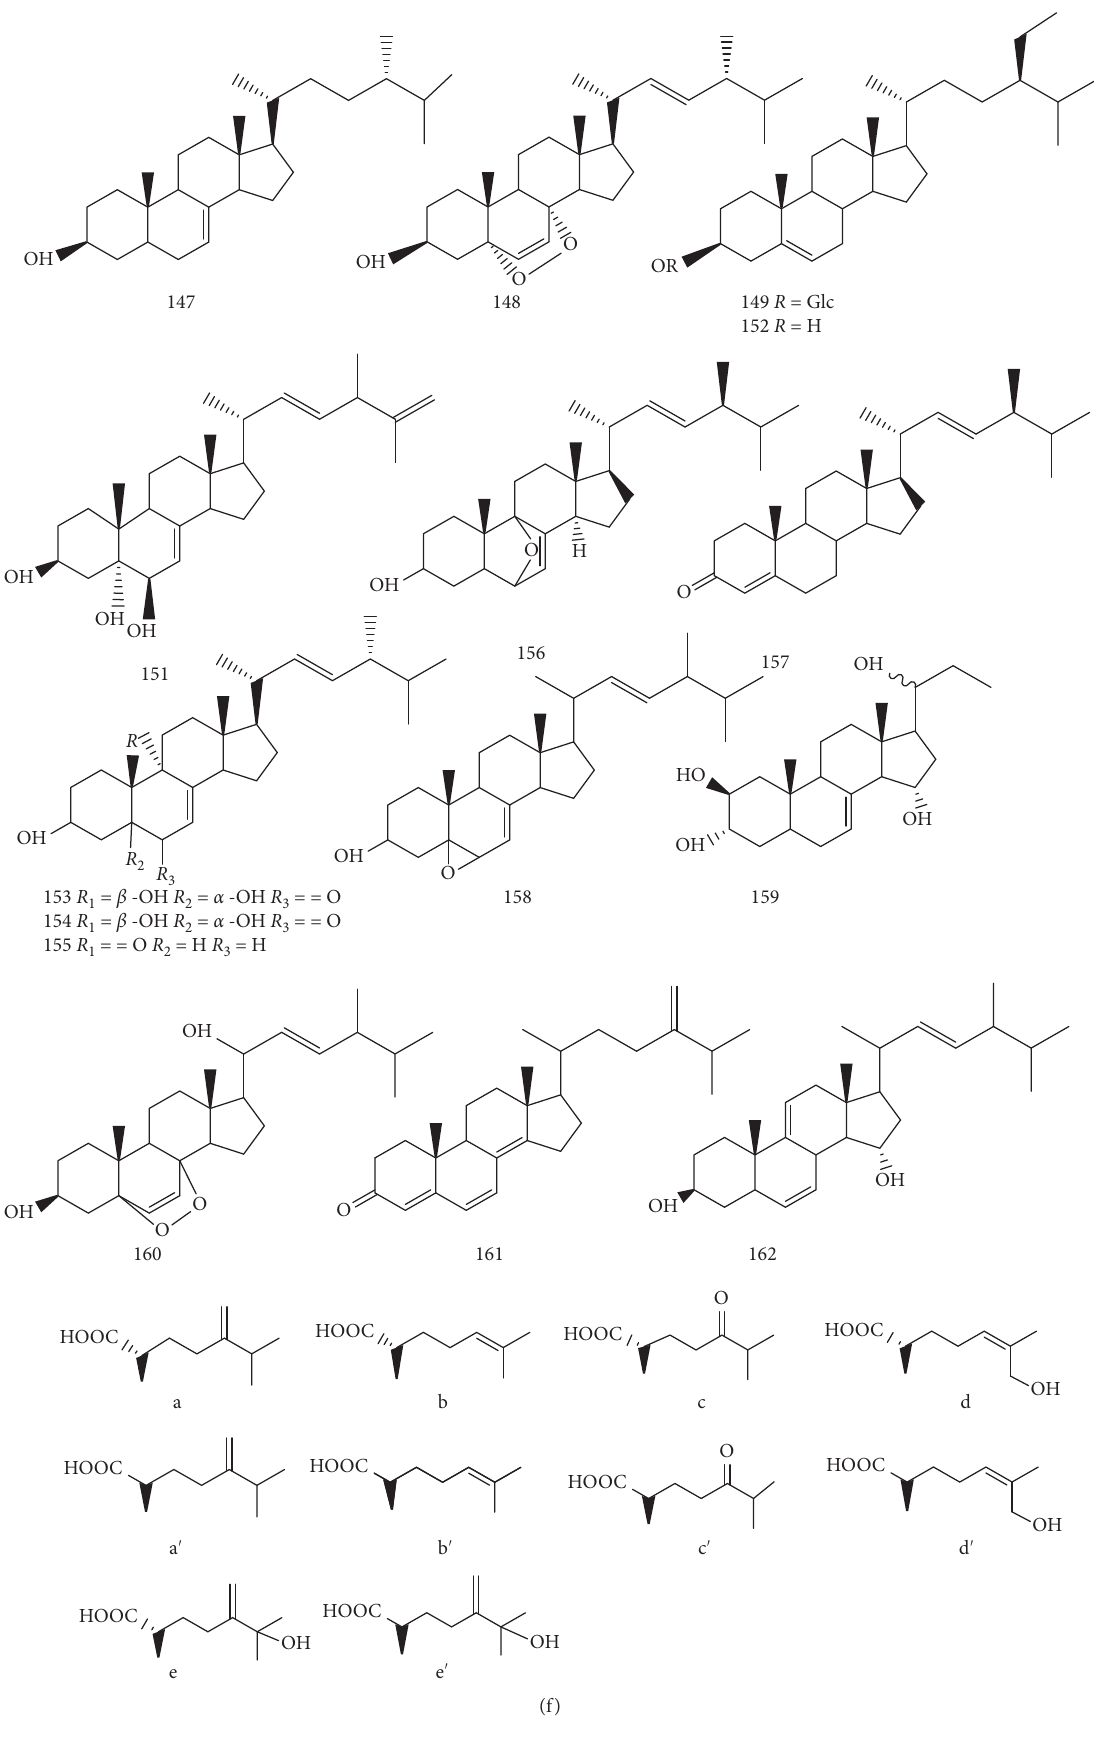
Figure 1: Structures of terpenoids isolated from Poria